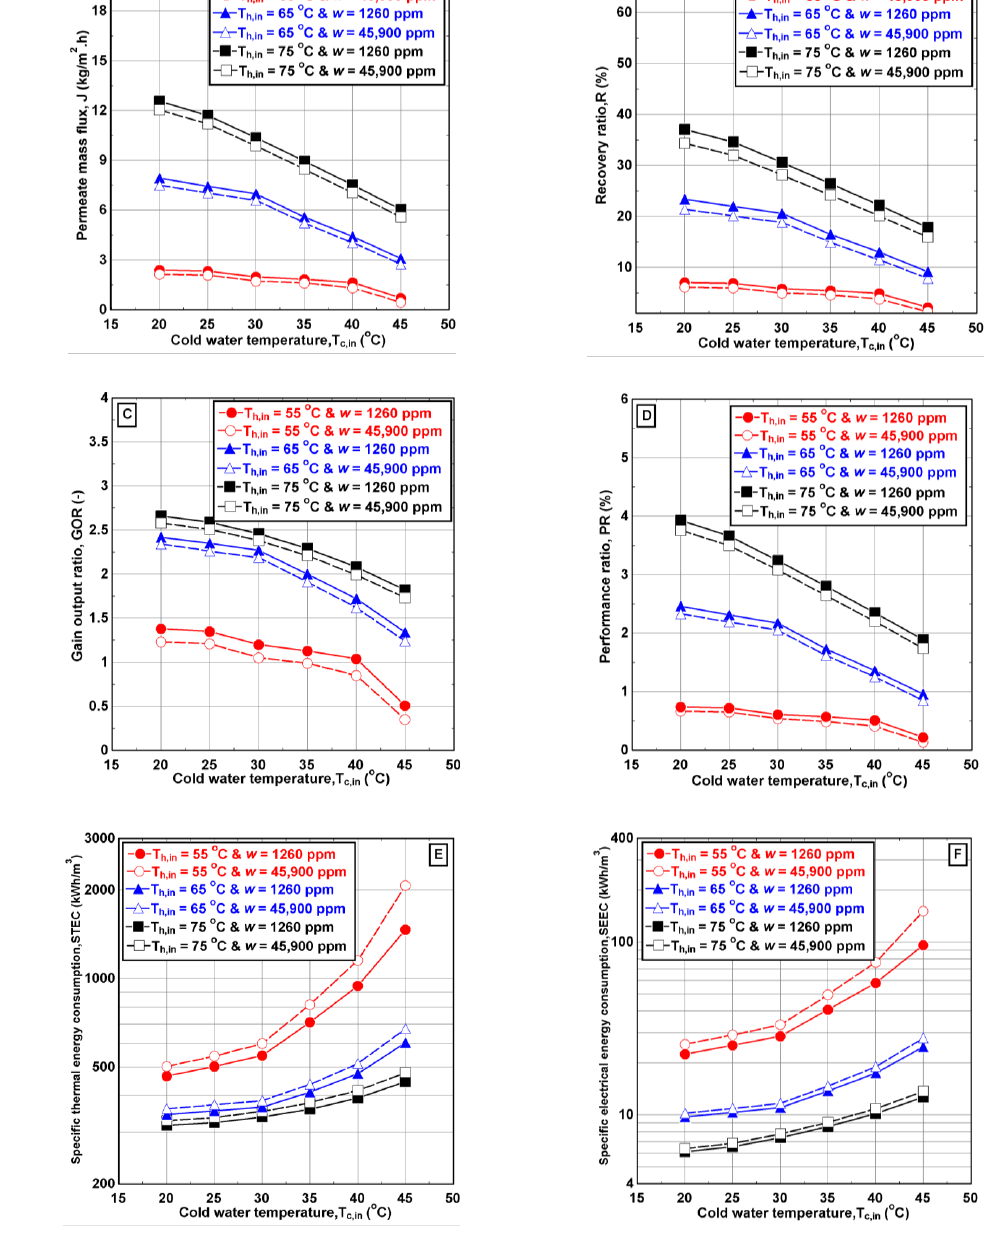
Figure 9. Effect of cold water temperature, T c , in , on ( A ) permeate mass flux, ( B ) recovery ratio, ( C ) gain output ratio, ( D ) performance ratio, ( E ) specific thermal energy consumption, and ( F ) specific electrical energy consumption for different hot water temperatures and salinities ( 𝑉̇ ℎ = 840 L/h, 𝑉̇ 𝑐 = 405 L/h, 𝑉̇ 𝑓 = 87 L/h, T f , in = 25 °C, and P a , vac = 115 mbar).